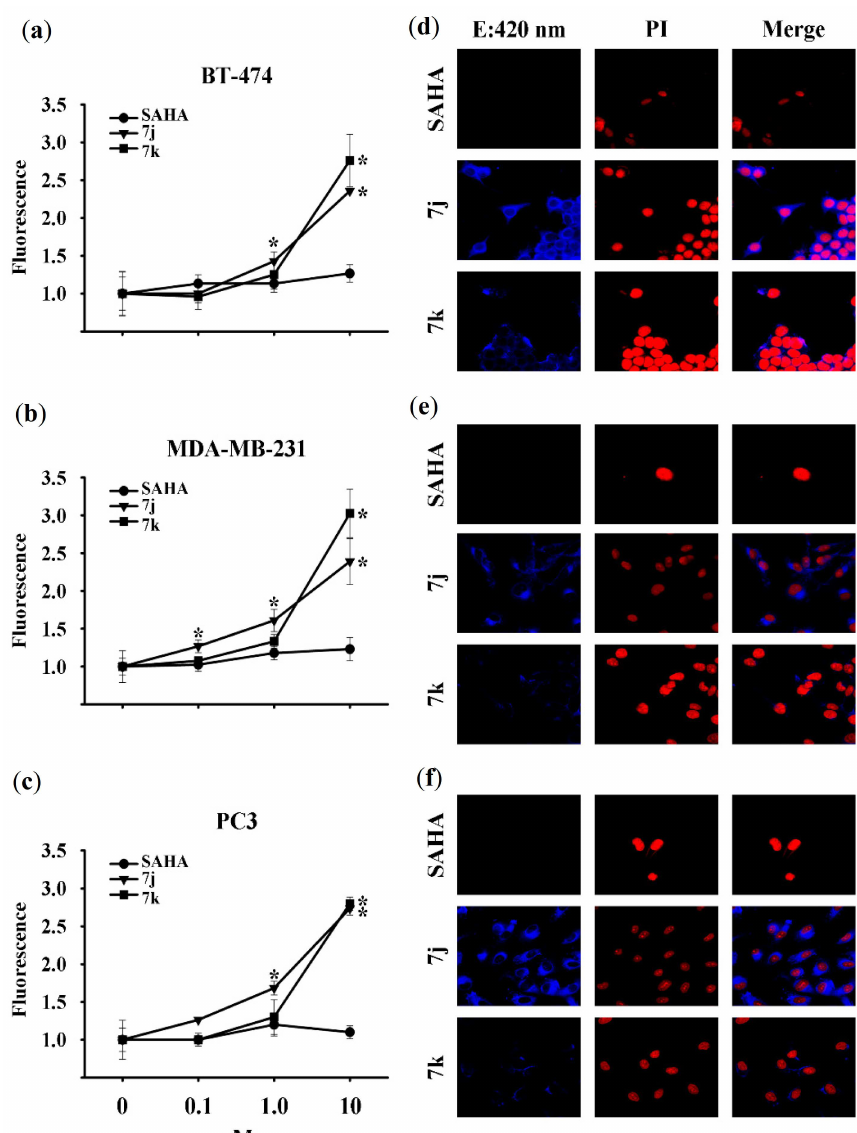
Figure 5. Relative fluorescence emission intensity and subcellular location of compounds 7j and 7k . ( a – c ) Breast and prostate cancer cells were treated in the presence (at di ff erent concentrations) and absence of the two compounds, followed by spectrofluorometric quantification. The value of vehicle-treated cells was set to one. * p < 0.05 vs vehicle. ( d – f ) Fluorescence microscopy of 7j and 7k in the three cell lines. Blue = 7j , 7k . Red = propidium iodide (PI). Blue / red = merged image of 7j , 7k and PI. Representative images from two independent experiments are